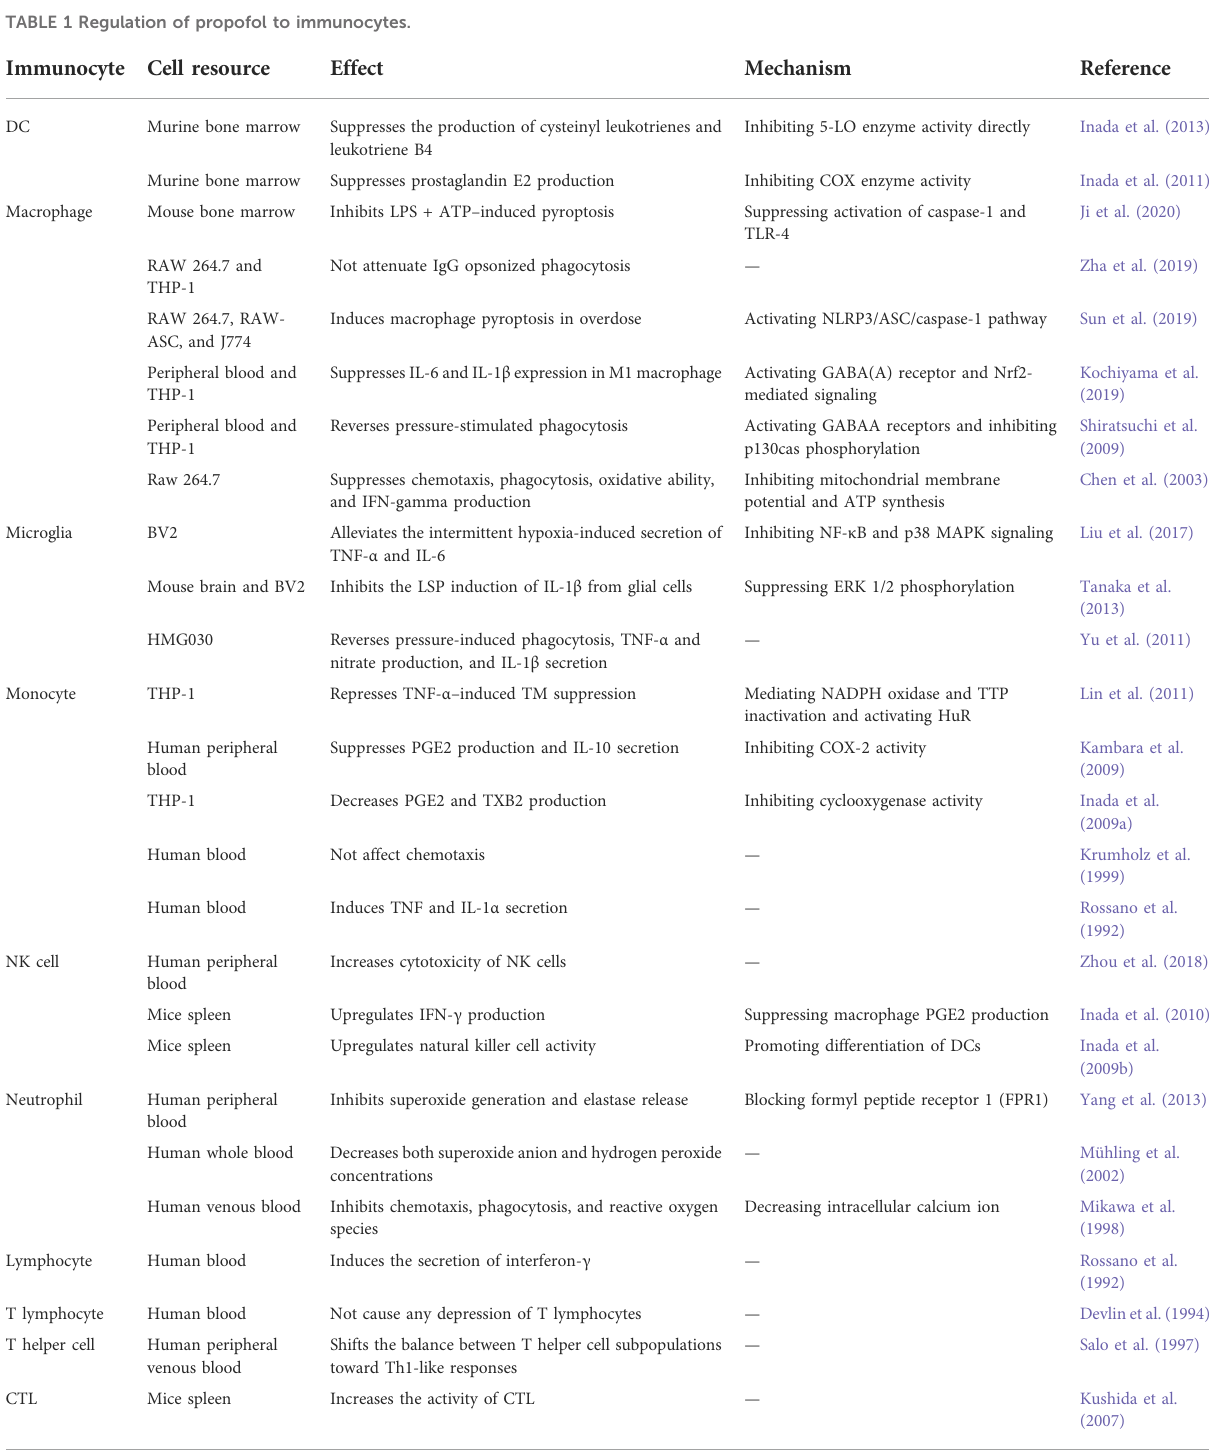
TABLE 1 Regulation of propofol to